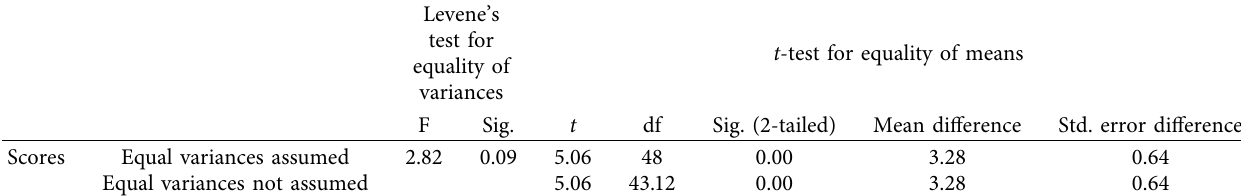
Table 6: Inferential statistics of both groups on the delayed vocabulary